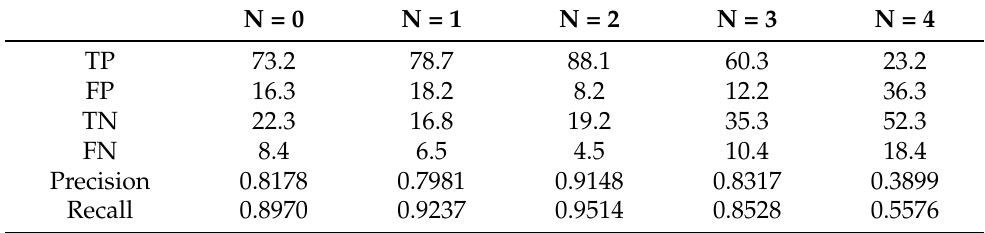
Table 3. The table describes the calculated precision and recall values by varying the number of IoC pairs that must be satisfied to be classified into a group. All values are rounded to the second decimal